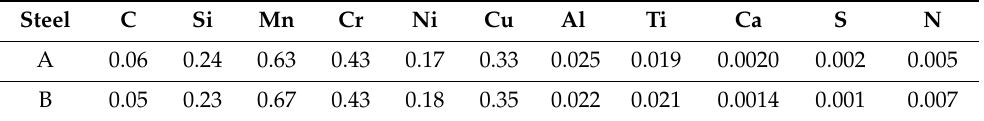
Table 1. Contents of main elements in steels from both heats (wt%).